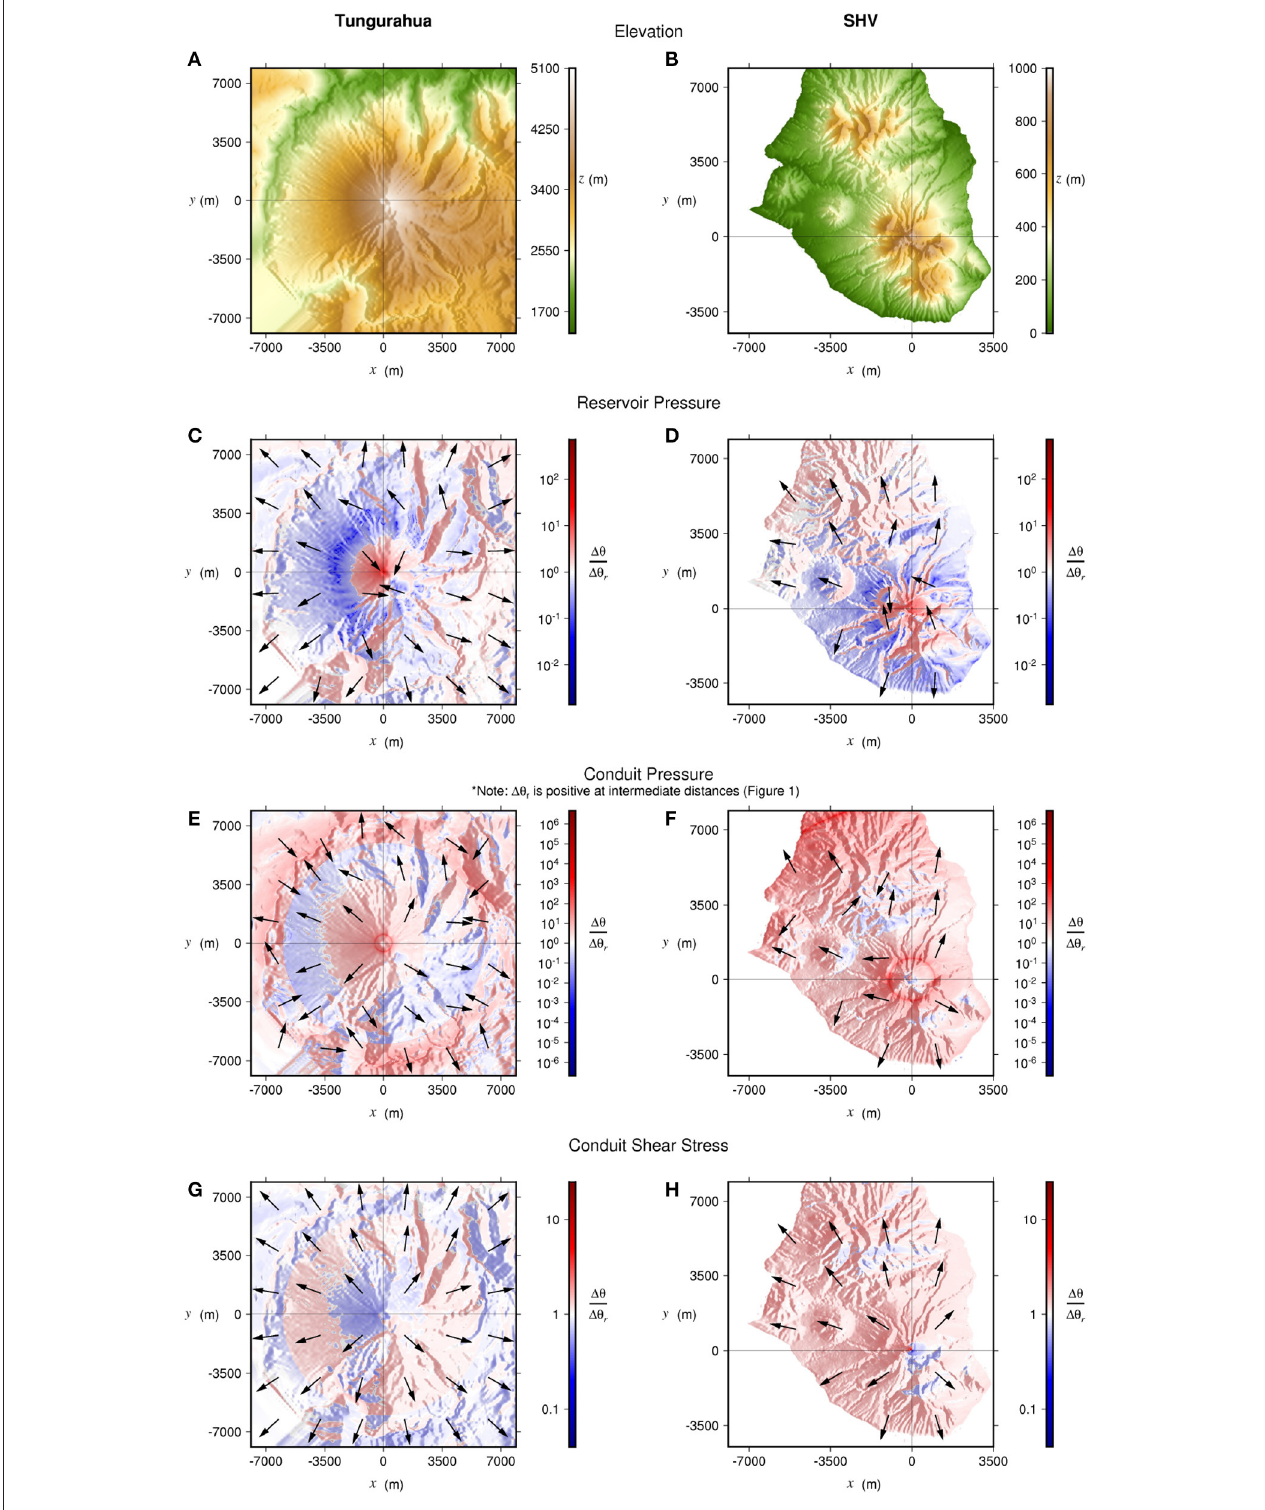
FIGURE 9 | DEMs of Tungurahua volcano (left) and SHV (right) (A,B) . Amplification factor due to the topographic effect on tilt produced by reservoir pressure (C,D) , conduit pressure (E,F) , or shear stress (G,H) . The arrows depict the orientation of the maximum tilt. Note that this is often not radial to the source, located at x = 0 m, y = 0 m in each